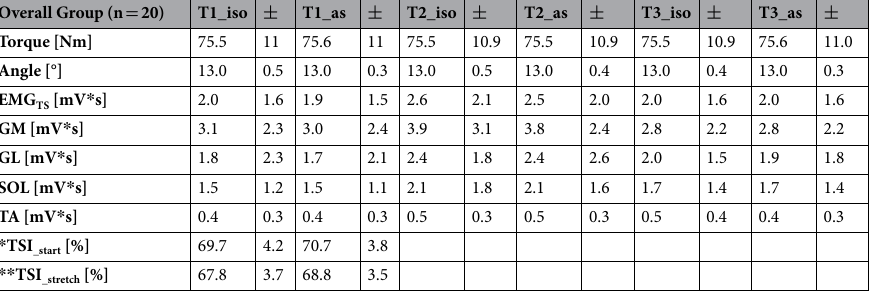
Table 1. Mean and standard deviation ( ± ) of all subjects during pure isometric (iso) and active stretch (as) contractions at three analysed windows. T1 = 4–20 s after stretch. T2 = 20–40 s after stretch. T3 = 40–55 s after stretch. Torque = Plantar flexion torque. Angle = Angular position at the reference position. EMG TS = Triceps surae. GM = Gastrocnemius medialis. GL = Gastrocnemius lateralis. SOL = Soleus. TA = Tibialis anterior. Torque and angle data represent mean data. GM, GL, SOL and TA represent integrated data. * TSI =